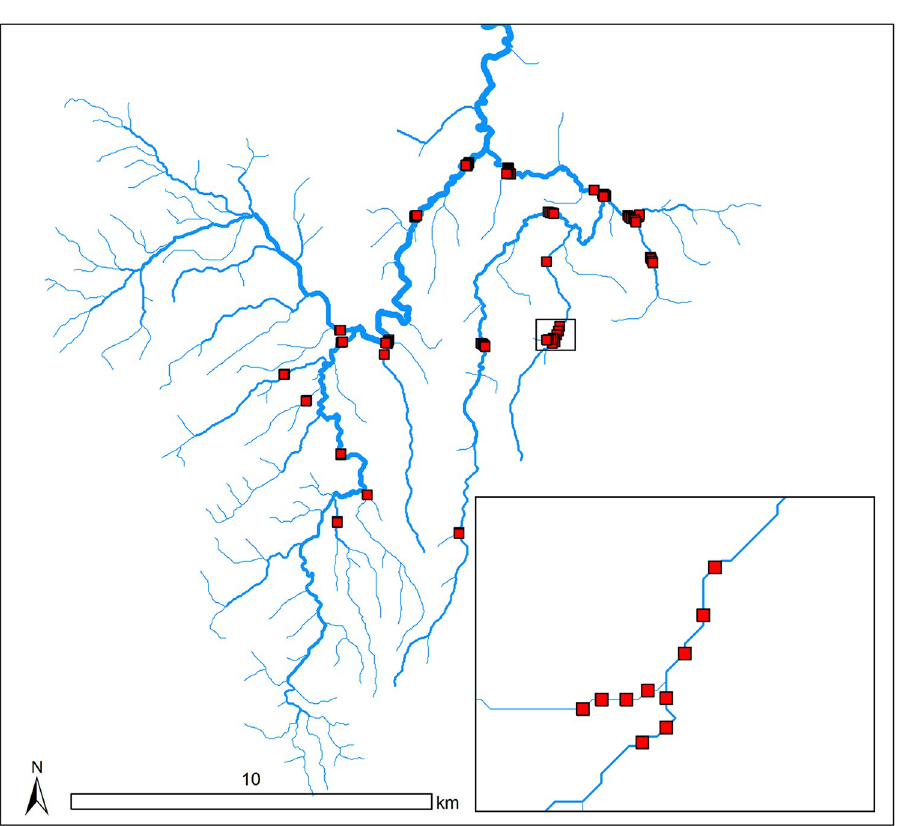
Fig 3. The Lake Eacham stream network (blue lines) with all potential sampling sites (red squares). The width of the stream lines is proportional to the catchment area for each stream segment. The inset shows the spatial distribution of sampling sites around a confluence in the stream